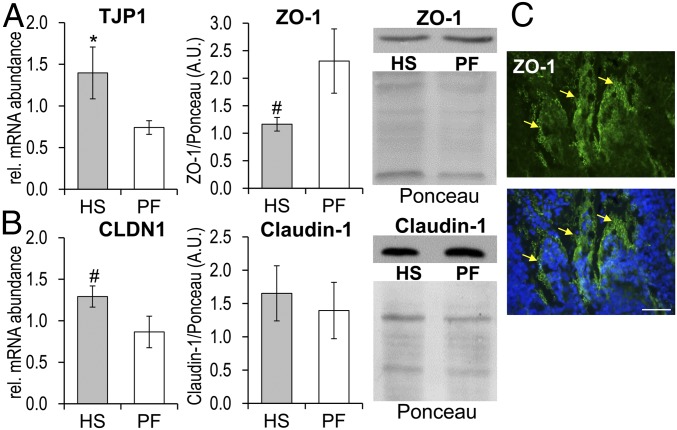
Heat stress induces alterations of TJPs abundance in jejunal mucosa. (A) TJP1 mRNA and protein abundance (ZO-1) with one representative Western blot for HS and PF cows. (B) CLDN1 mRNA and protein abundance with one representative Western blot for HS and PF cows. Data were normalized to total protein after Ponceau staining. (C) Immunohistochemical staining of the jejunum using an antibody specific for ZO-1. (Scale bar, 50 µm.) n = 5 (means ± SEM). *P < 0.05 and #0.05 < P < 0.1.